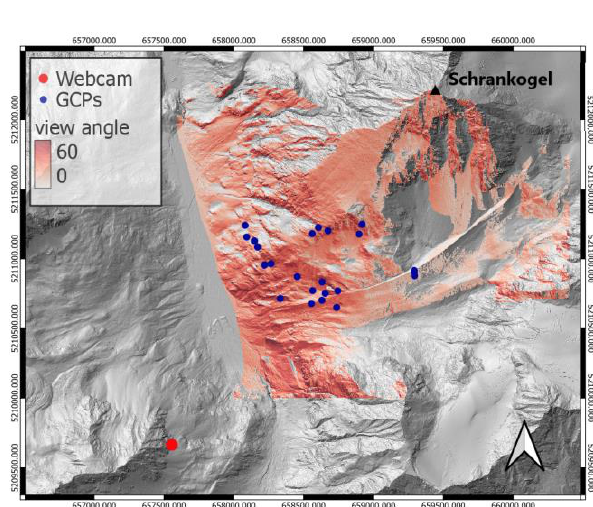
Figure 1. Study area below Mt. Schrankogel, with the webcam location (red), all ground control points (of which 11 were accurate enough for image processing) and the terrain view angle of the camera masked for the area of interest and areas in sight of the